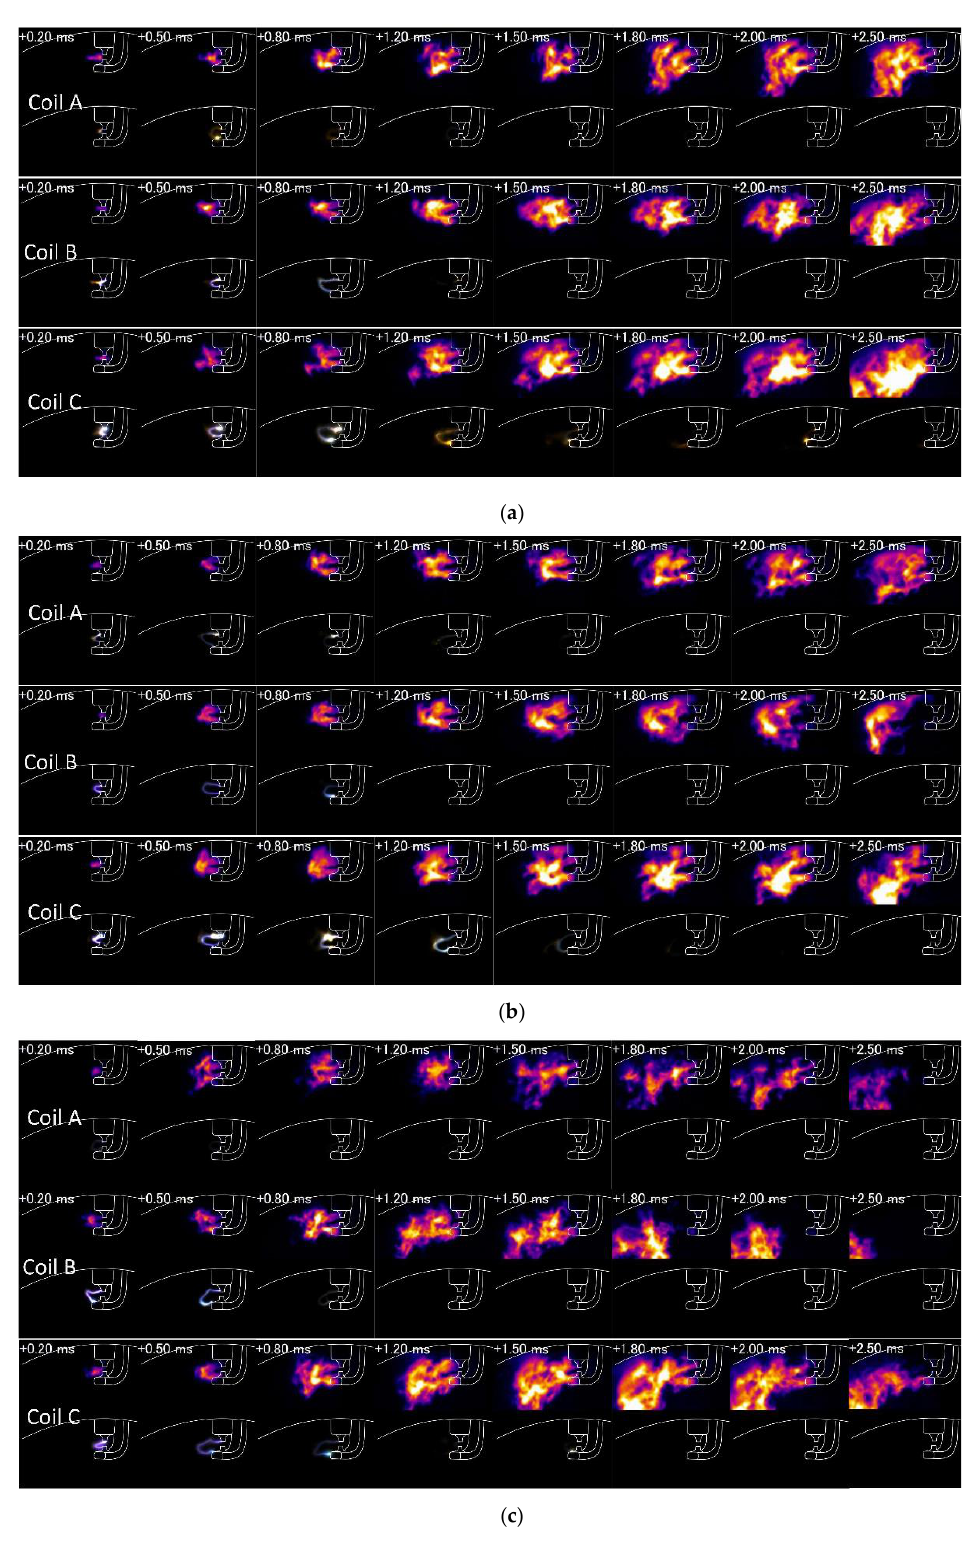
Figure 10. Simultaneous visualization results of different ignition coils (upper: CO radiation im- ages/lower: direct photographs. Basic condition with the N 2 dilution of 24% and flow velocity of 8 m/s, high diluted condition with the N 2 dilution of 28% and flow velocity of 8 m/s, high flow condition with the N 2 dilution of 24% and flow velocity of 18 m/s): ( a ) Basic condition; ( b ) High diluted condition; ( c ) High flow